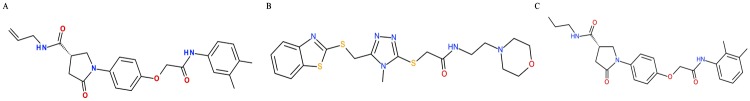
2D structures of the hit compounds.